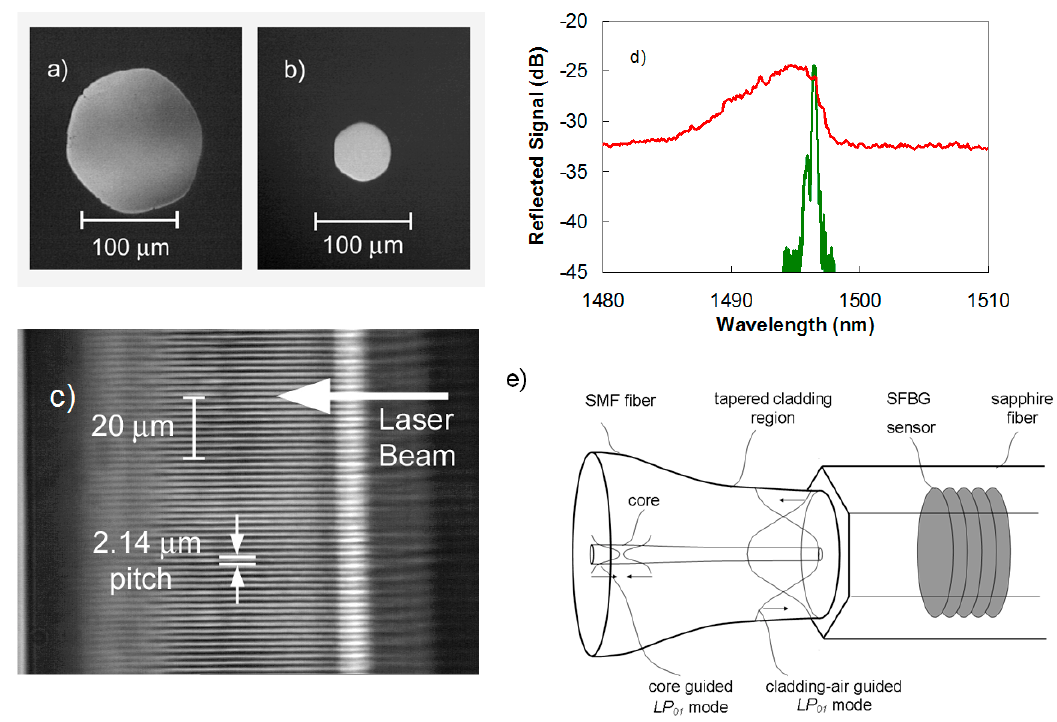
Figure 14. Cross-sections of commercially available ( a ) 125 µm and ( b ) 60 µm diameter sapphire fiber are shown; the grating structure inscribed in 150 µm diameter fibre is shown in ( c ); the corresponding multimode reflection response is shown by the red trace in ( d ); when using the single-mode field expander shown in ( e ), the single-mode reflection spectrum shown in green in ( d ) is obtained.